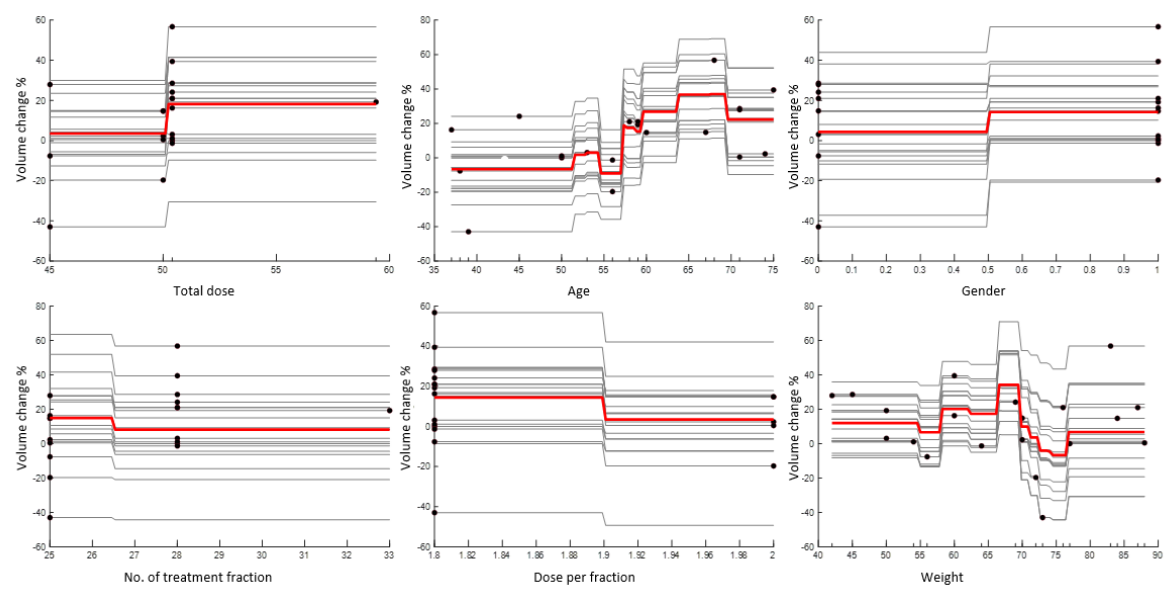
Figure 2. A PDP plot (red line) and ICE plots (grey lines) for each predictor. A scatter plot (circle markers) of the selected predictor and predicted responses is also included.